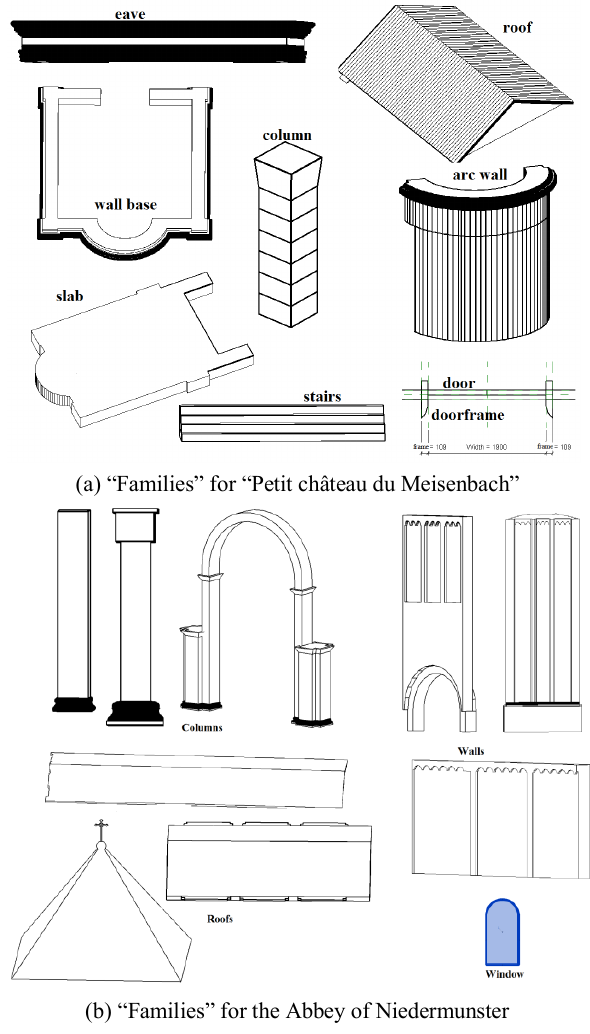
Fig. 3. The parametric primitives created as Revit “Families”